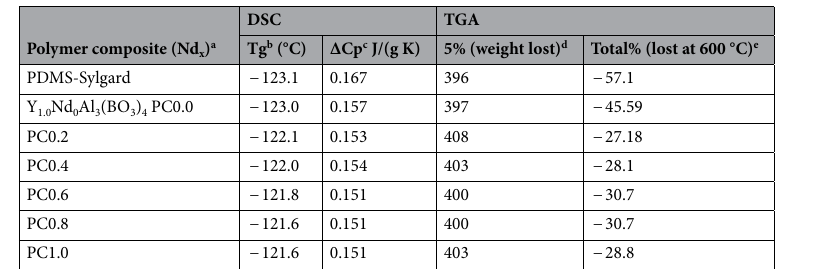
Table 2. Thermal properties of polymer composite with Nd:YAB. a Polymer composite containing Nd concentrations of Nd x Y 1–x Al 3 B 4 O 12 with x = 0.2, 0.6, 0.8, and 1.0. b,c Obtained by DSC under a helium atmosphere with heating rate of 10 K/min. d,e Obtained by TGA under 25 mL/min stream nitrogen atmosphere with constant heating ramp of 10 °C/min.